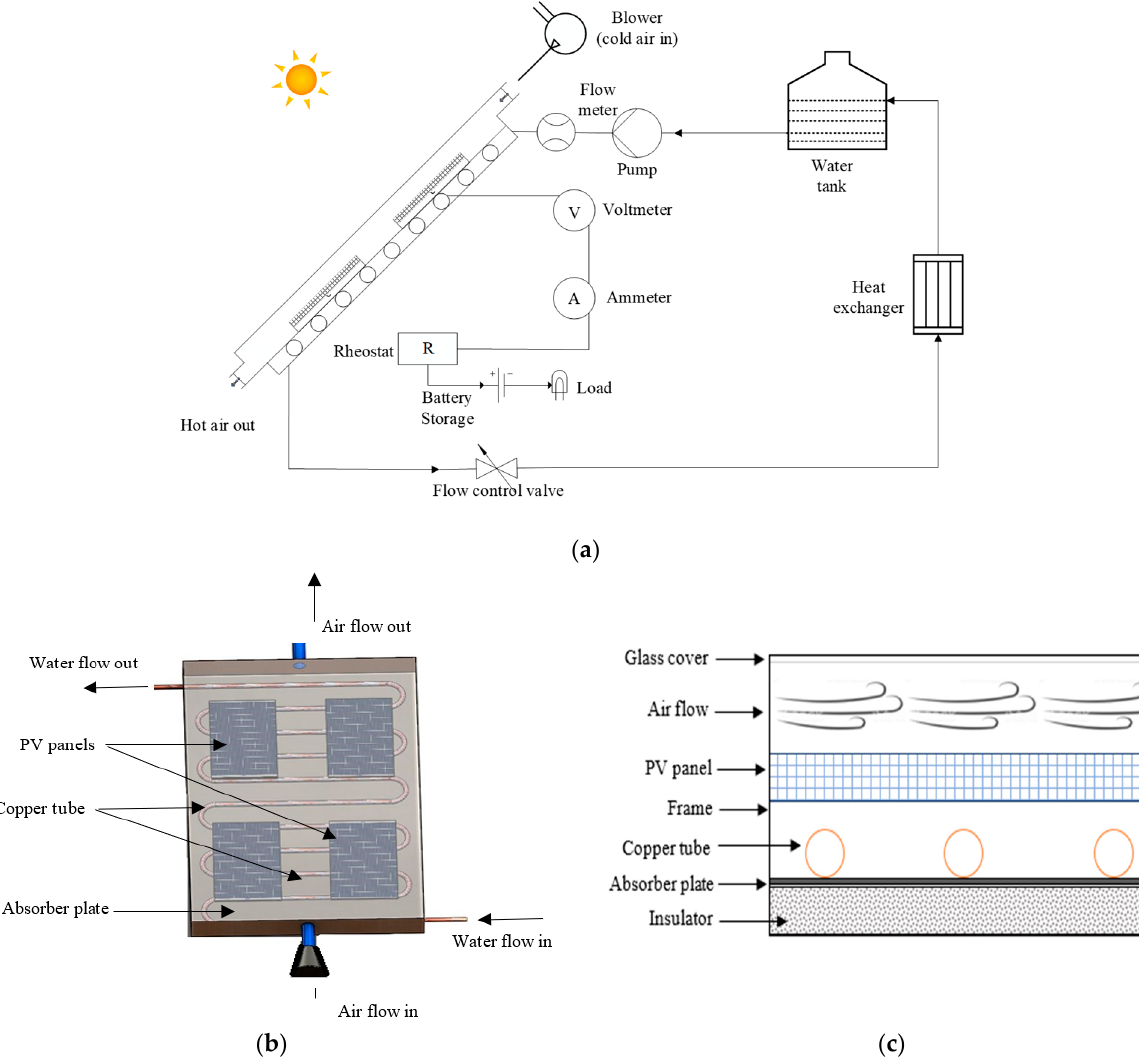
Figure 1. ( a ) Schematic diagram of the experimental setup, ( b ) front view of the collector, and ( c ) cross-sectional view of the collector.